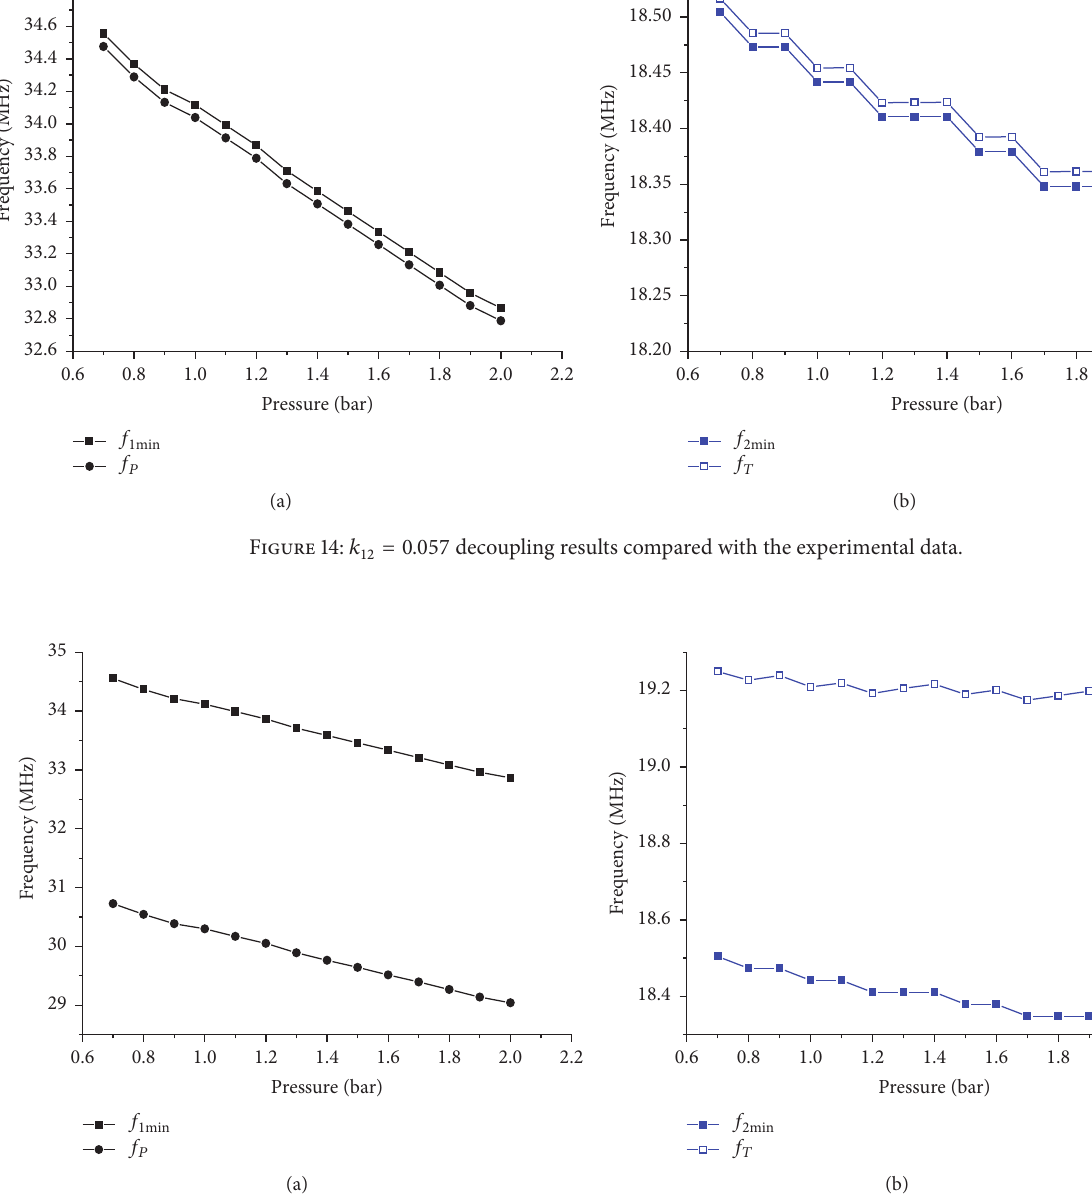
Figure 15: 𝑘 12 = 0.216 decoupling results compared with the experimental